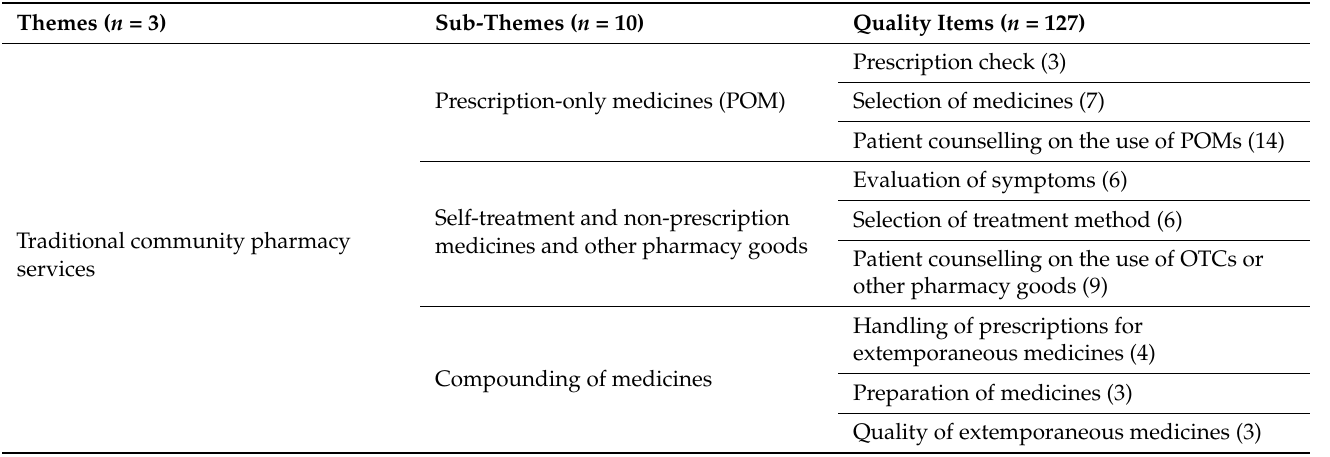
Table 1. Indicators used in the implementation survey of the Community Pharmacy Services Quality Guidelines ( n = 127). Themes ( n = 3) Sub-Themes ( n = 10) Quality Items ( n = 127)